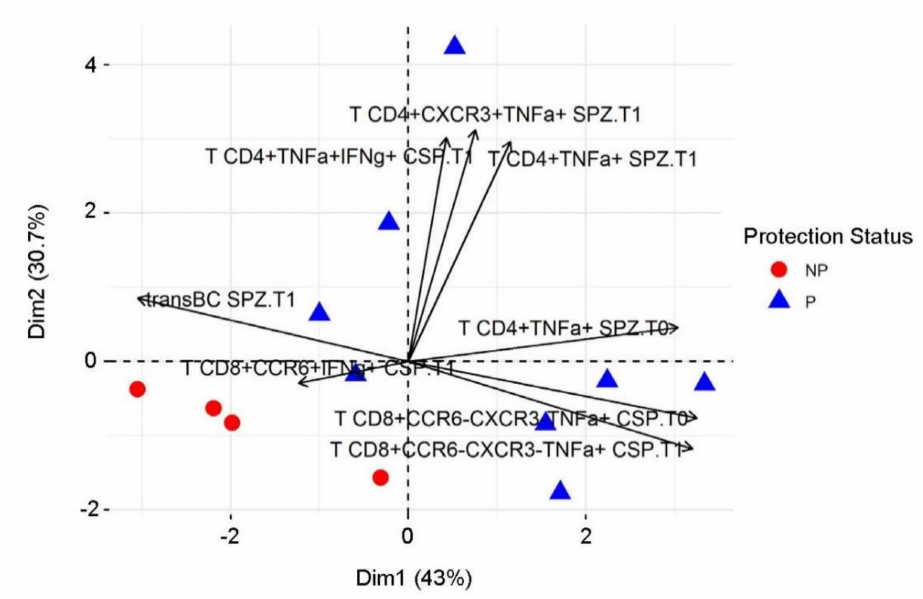
Figure 7. Principal component analysis of protection. Twelve individuals with a complete dataset were plotted on the first (Dim1) and second (Dim2) principal components of a principal component analysis. The color and shape of the dots (which represent individual samples) indicate protection